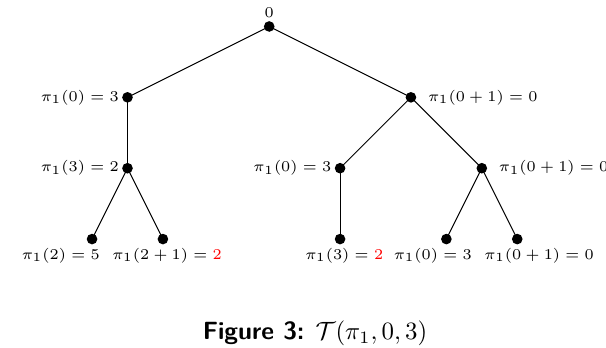
Figure 3: T ( π 1 , 0 ,